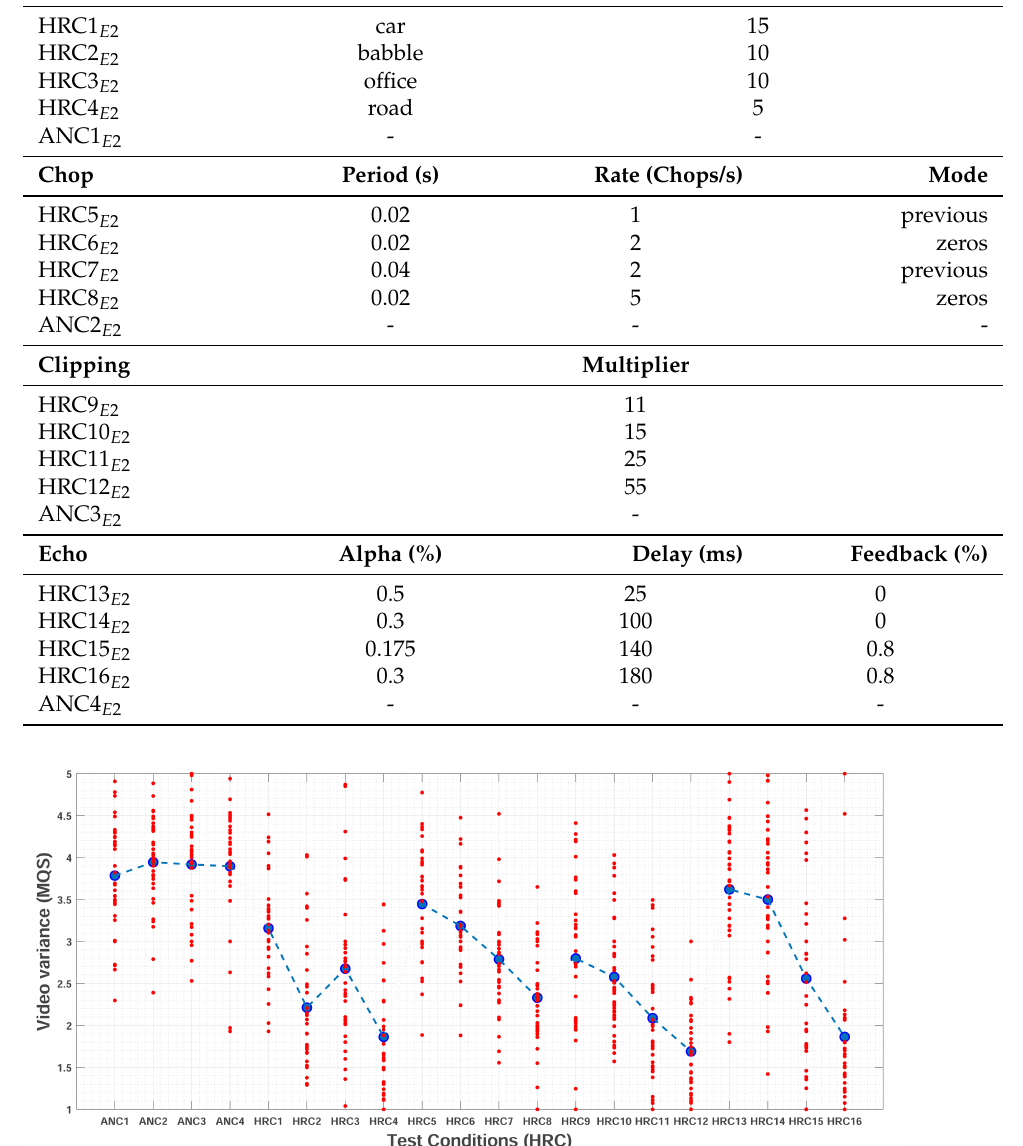
Figure 7. Mean Quality Score (MQS), and its respective spread of scores, for the different Hypothetical Reference Circuit (HRC) in Experiment